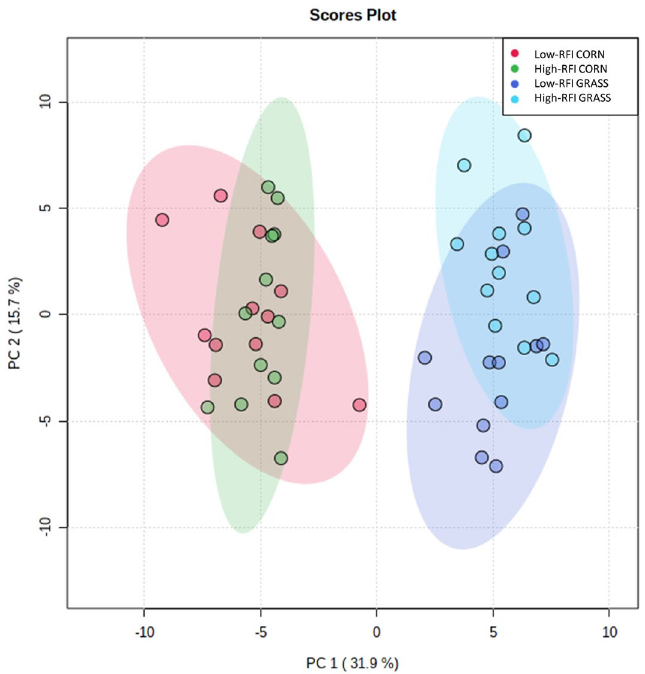
Figure 1. Score plots for principal components analysis (PCA) comparing Low-RFI versus High-RFI animals fed corn- or grass-silage diets based on all quantified metabolites